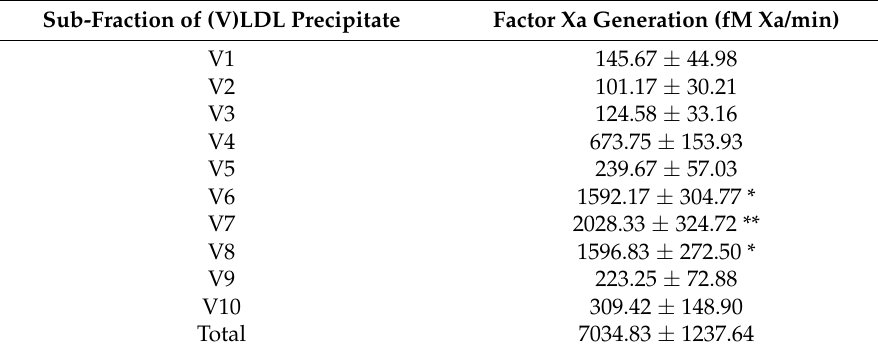
Table 2. Procoagulant activity in the density gradient sub-fractions of the (V)LDL precipitate. Sub-Fraction of (V)LDL Precipitate